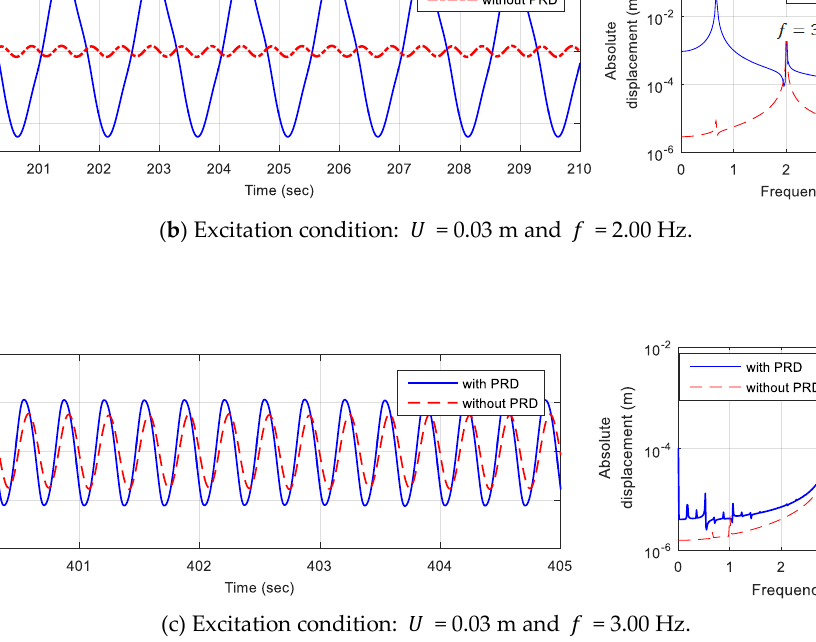
( a ) Time response.